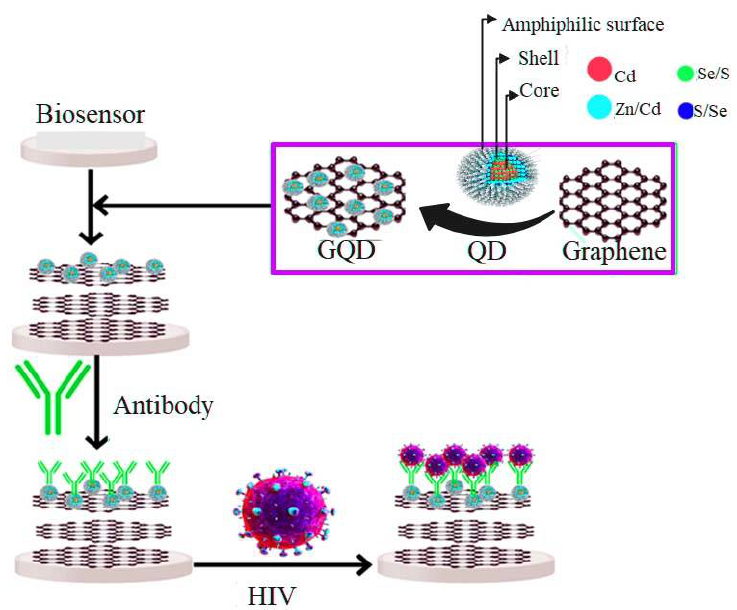
Figure 5. The GQD for detecting HIV.